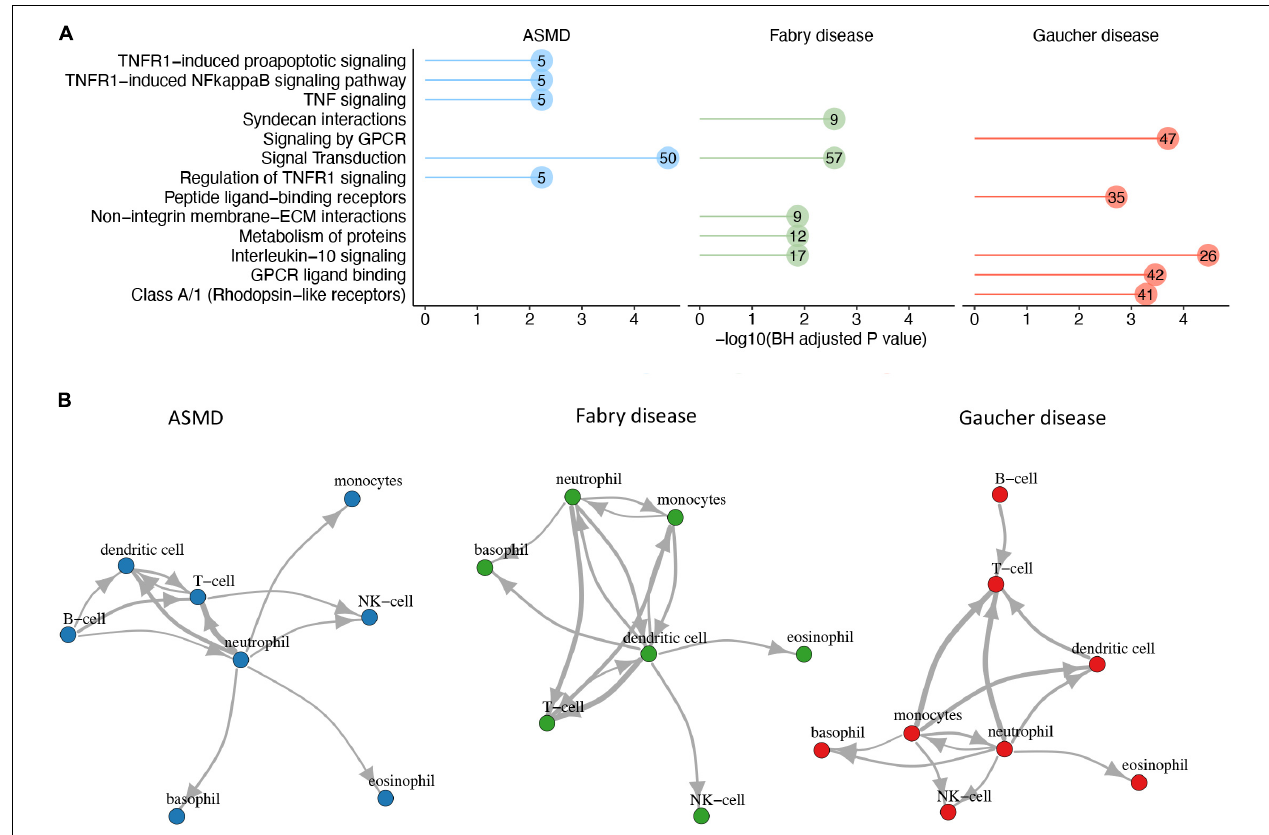
FIGURE 5 | Cytokine-receptor analysis to build cell-cell networks. (A) Functional enrichment analysis. For each disease, the top 5 Reactome pathways enriched in disease cytokines and their receptors are shown. The numbers within the dots indicate the number of cytokines/receptors belonging to the pathway. (B) For each disease, the top cell-cell interactions involving the literature-derived cytokines and their receptors are shown. The cell-cell interactions were scored based on the number of CR pairs involved, and those above the 75th percentile are shown in the network chart. The thickness of the edge is proportional to the number of interacting CR pairs that in ASMD network ranges from 20 to 34, in FD network from 28 to 44 and in GD from 33 to